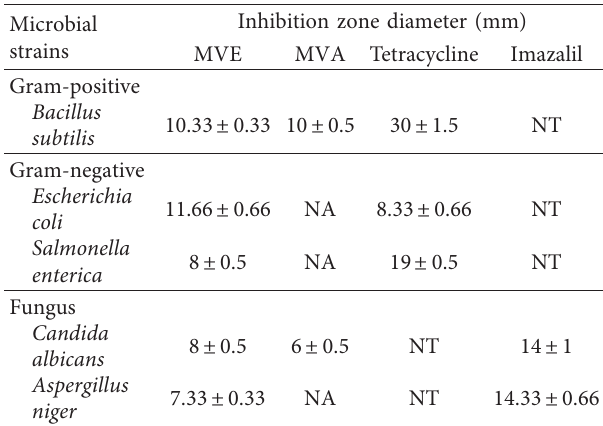
Table 3: Inhibition zone of MVE and MVA extracts of M. vulgare leaves against pathogenic microbial